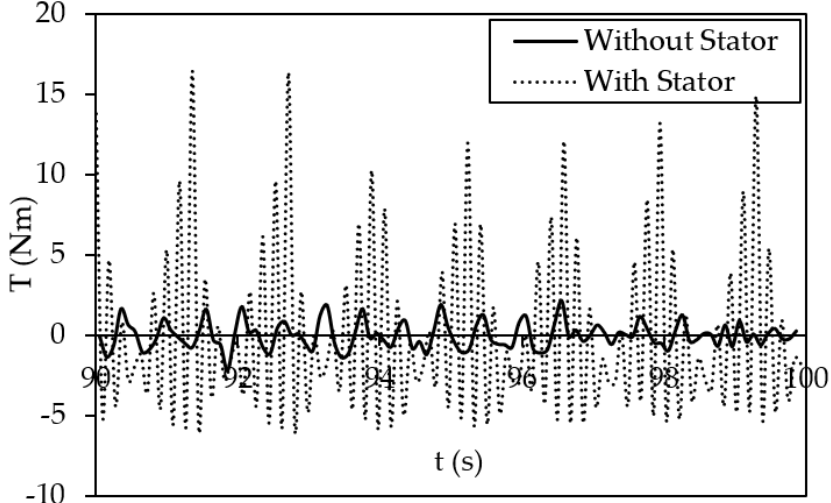
Figure 11. Variations in the torque generated by the VAWTs with and without Stator.